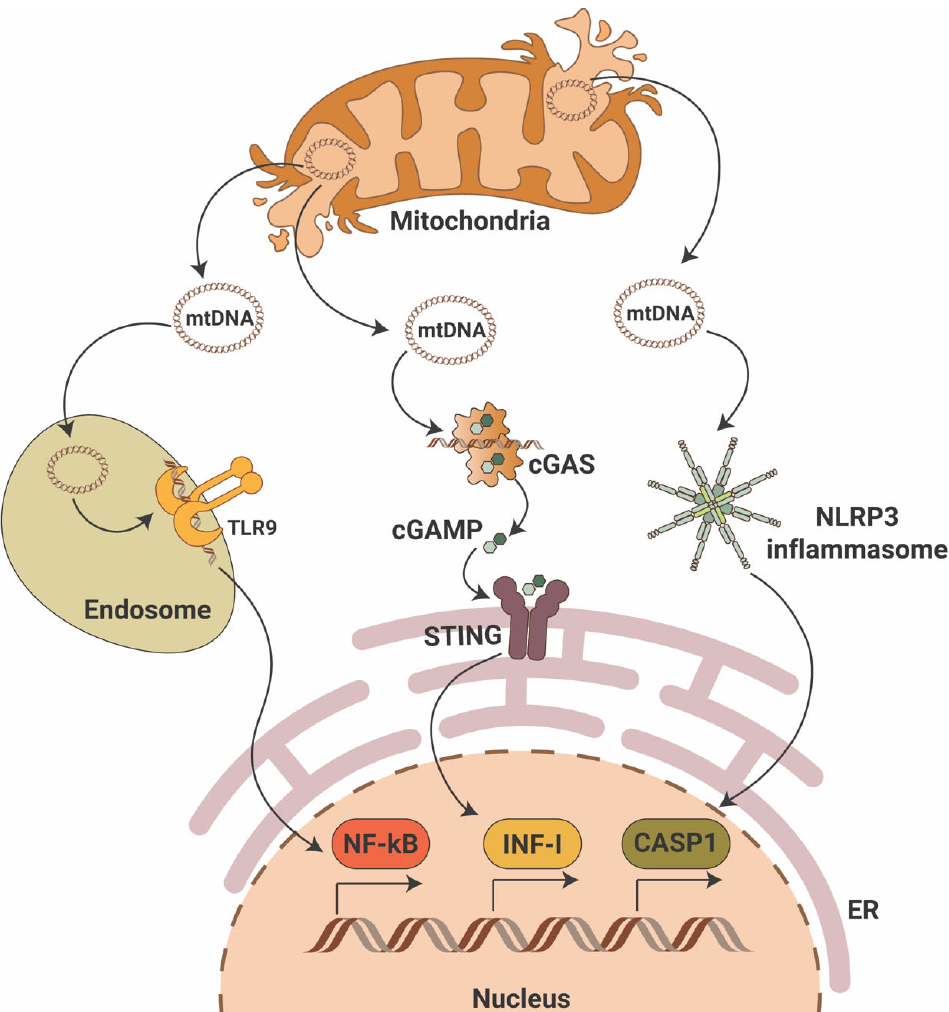
Figure 1. Mitochondrial DNA triggers pro ‐ inflammatory signaling pathways. Mitochondrial DNA (mtDNA) can activate three major pro ‐ inflammatory signaling pathways that include endosomal toll ‐ like receptor 9 (TLR9) with activation of nuclear factor κ B (NF ‐κ B), the cyclic GMP ‐ AMP synthase (cGAS)/stimulator of interferon gene (STING) with activation of interferon type I (INF ‐ I) and cytosolic NLR family pyrin domain containing 3 (NLRP3) inflammasome activation with induction of caspase ‐ 1 ‐ dependent apoptosis. ER—endoplasmic reticulum; cGAMP—2 ′ 3 ′‐ cyclic GMP ‐ AMP.